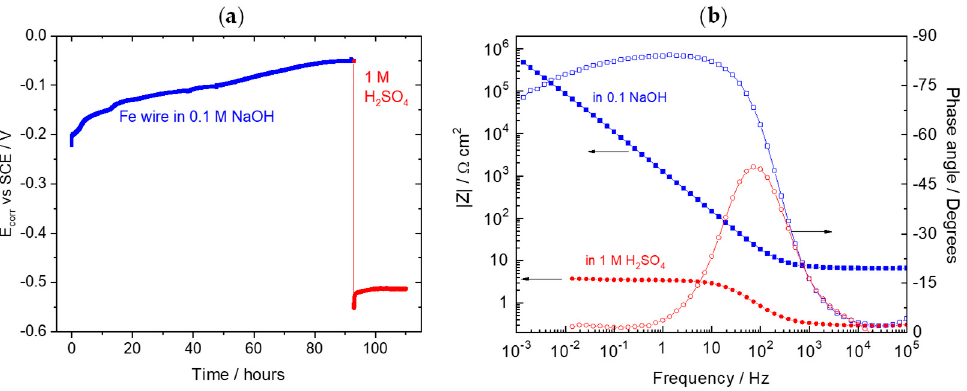
Figure 12. ( a ) OCP evolution of iron with solution change and ( b ) EIS response of an iron wire immersed in 0.1 M NaOH (blue) and then immersed in 1 M H 2 SO 4 (red).